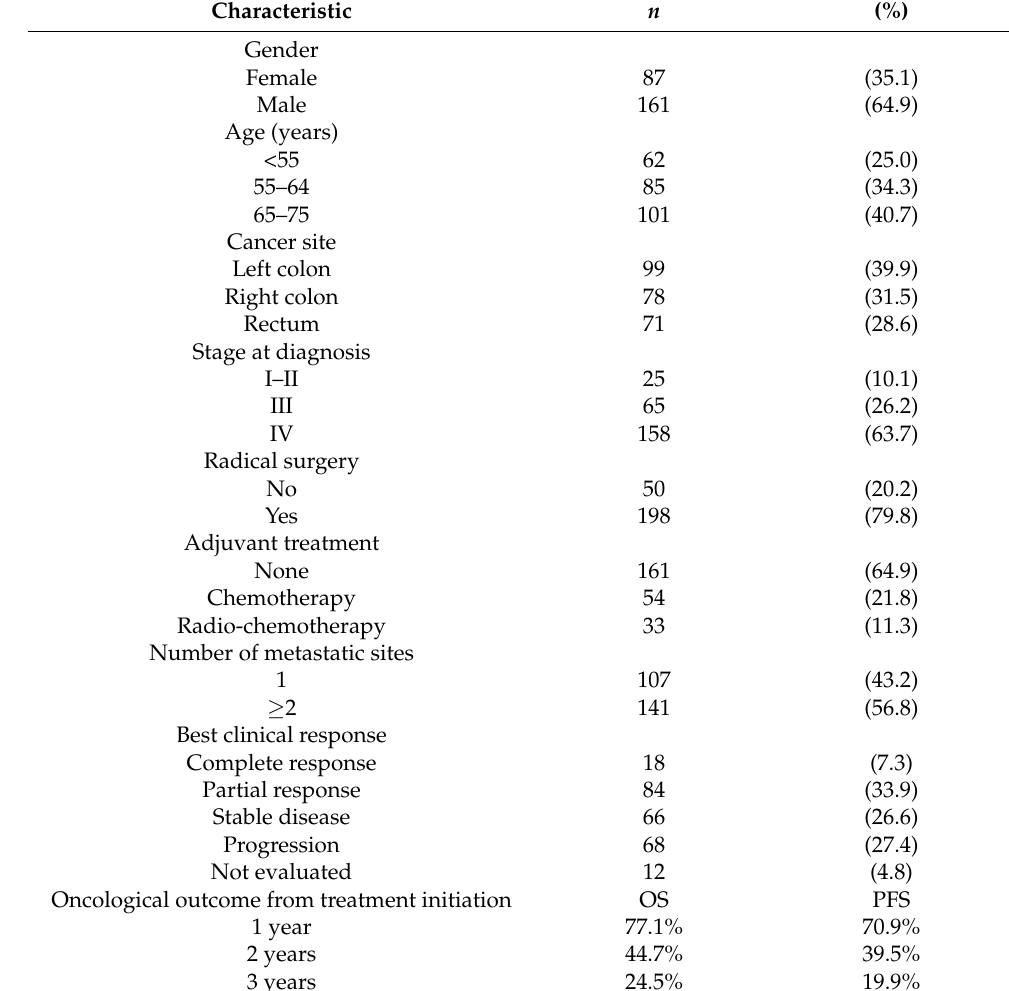
Table 1. Socio-demographic and clinical characteristics of 248 eligible patients with mCRC treated with first-line FOLFIRI